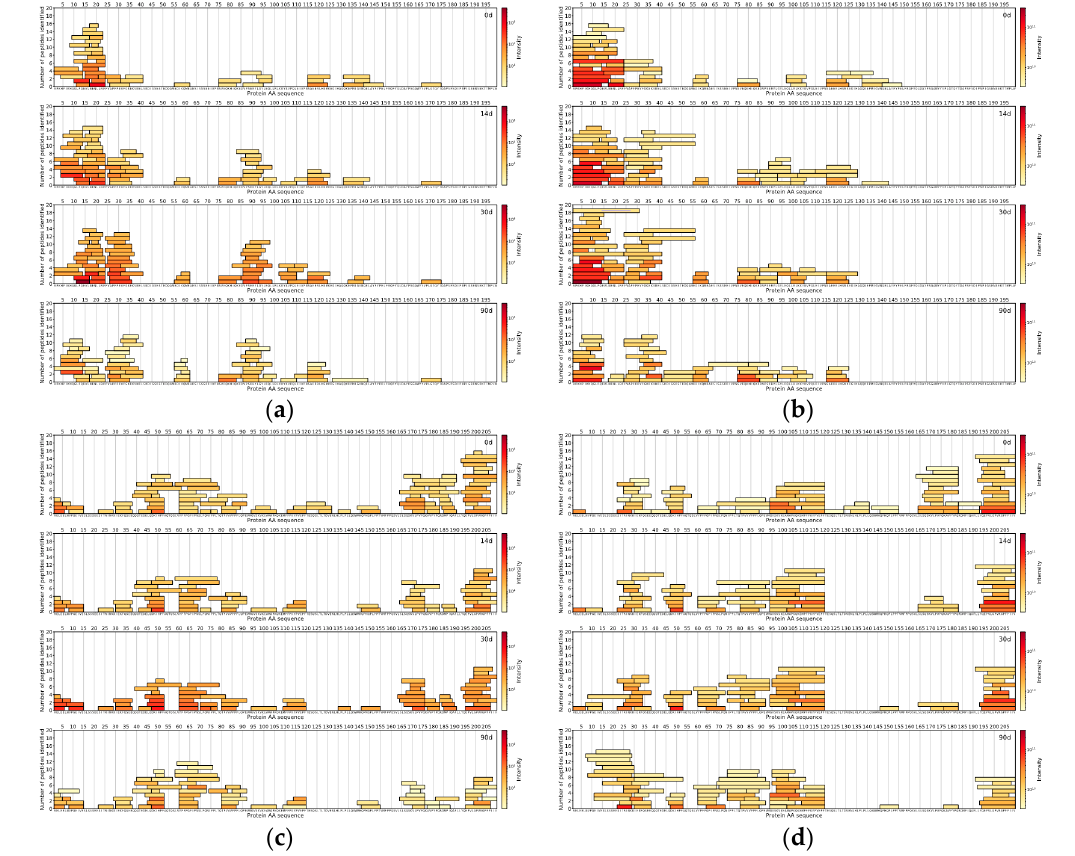
Figure 5. Cheese 2 α s1 -CN: ( a ) DIA-MS and ( b ) DDA-MS. Cheese 2 β -CN: ( c ) DIA-MS and ( d ) DDA-MS. The X -axis represents the casein amino acid sequence, the Y -axis represents a number of peptides and colour represents the logarithmically scaled intensity of peptides.